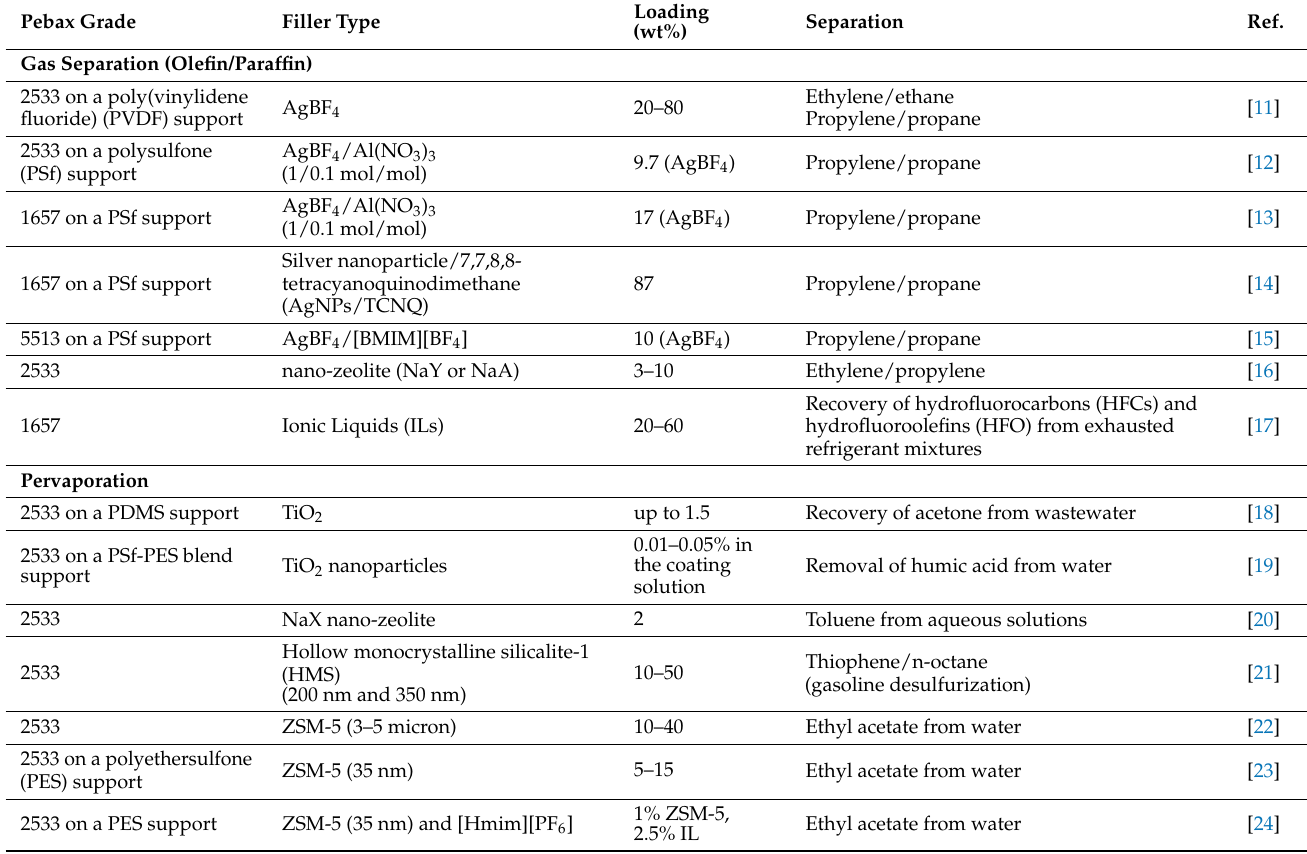
Table 2. Fillers utilized for developing membranes for separation